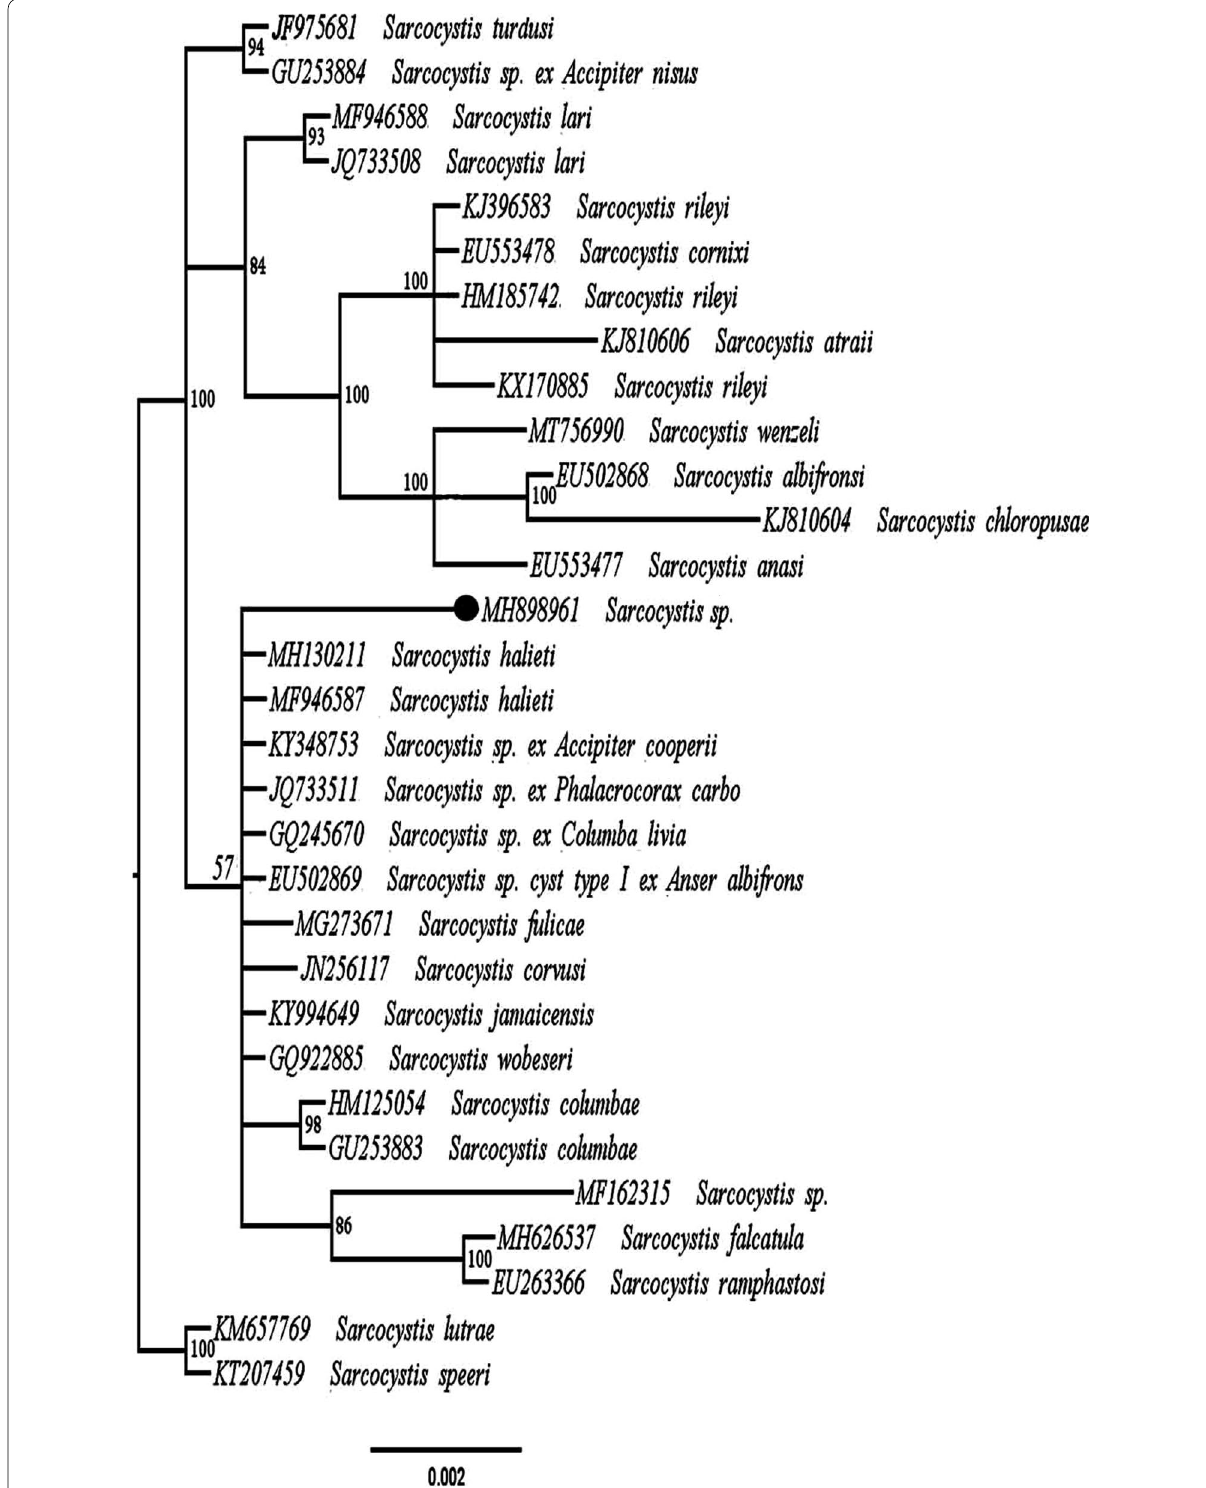
Fig. 2 Phylogenetic tree of the identified Sarcocystis sp., compared to other Sarcocystis taxa, using 18S rRNA